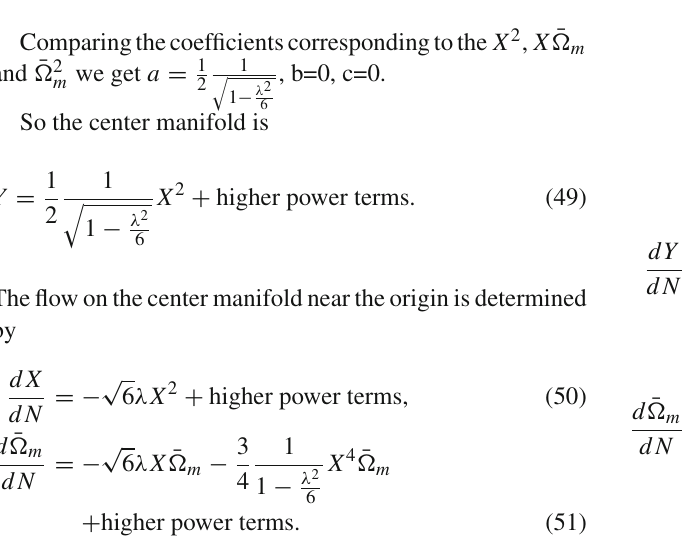
Fig. 5 Critical point P 3 for α + λ 2 = 3 and